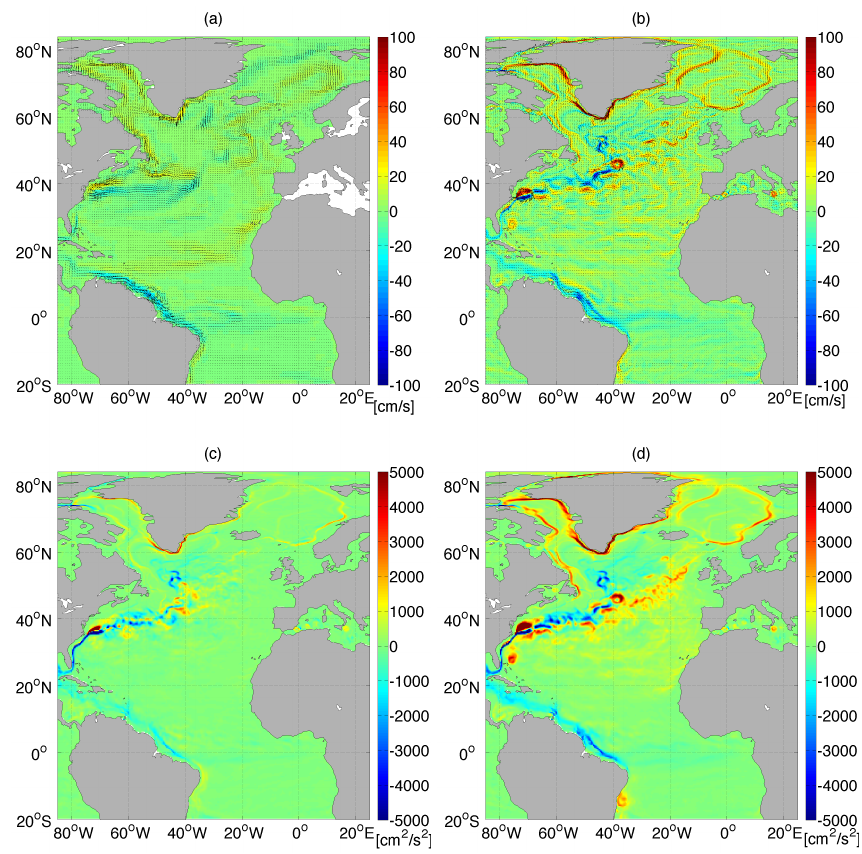
Figure 11. Changes of the horizontal velocity structure (in cms − 1 ) caused by the 0.5Sv perturbation after 50 model years (a) of the LR simulation and (b) of the HR simulation. Eddy kinetic energy (EKE) changes (cm 2 s − 2 ) for the HR 0.1Sv (c) and 0.5Sv (d) after 50 years.